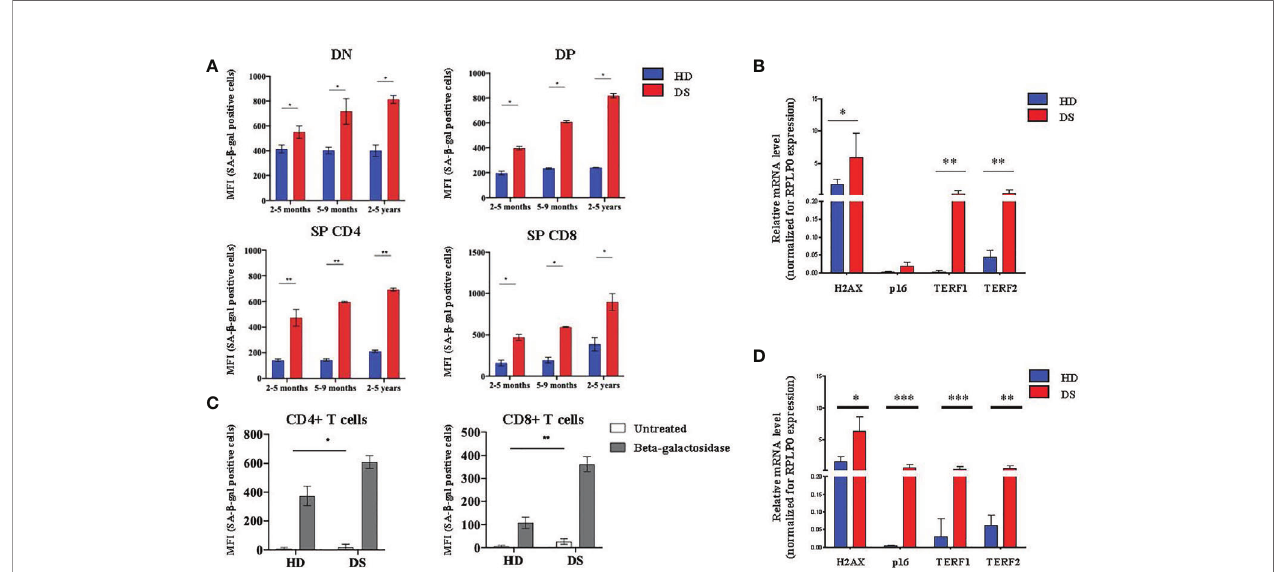
FIGURE 4 | Senescence detection in thymocytes and PBMCs. (A) MFI of SA- b -gal positive cells calculated on the gate of DN (CD45 + CD4 - CD8 - ), DP (CD45 + CD4 + CD8 + ), SP4 (CD45 + CD4 + CD8 - ) and SP8 (CD45 + CD4 - CD8 + ) thymocytes. HD and DS samples were divided in three age-groups: 2-5 months, 5-9 months and 2-5 years (2-5 months: HD, n = 3, samples 1, 3, 5 in Supplemental Table 2 ; DS, n = 3, samples 2, 3, 5 in Supplemental Table 3 . 5-9 months: HD, n = 3, samples 4, 6, 9 in Supplemental Table 2 ; DS, n = 3, samples 4, 8, 9 in Supplemental Table 3 . 2-5 years: HD, n = 3, samples 2, 7, 10 in Supplemental Table 2 ;